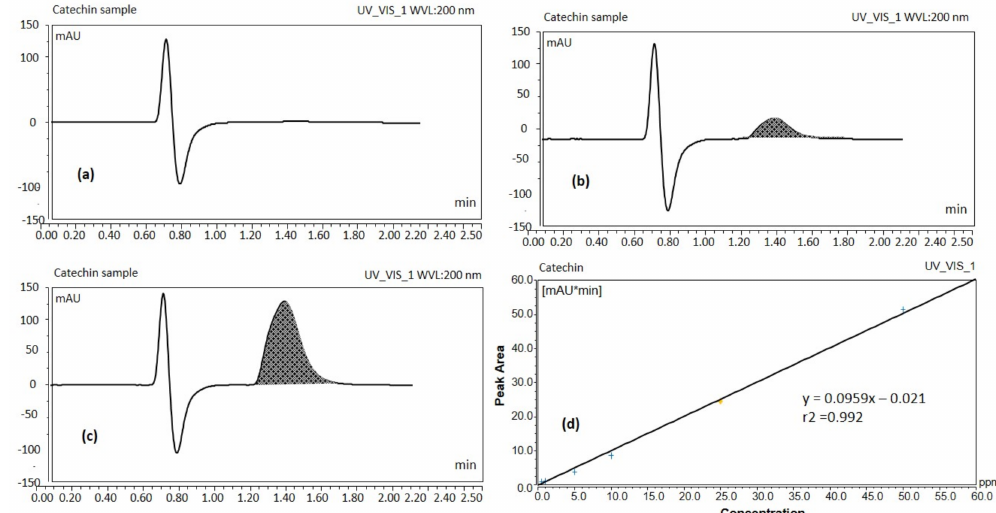
Figure 1. UHPLC chromatograms of blank sample ( a ), catechin standard solution 5 ppm ( b ), catechin of the real sample (green tea leaf extract solution) ( c ), UHPLC calibration curve of catechin ( d ) (UV detection at 200